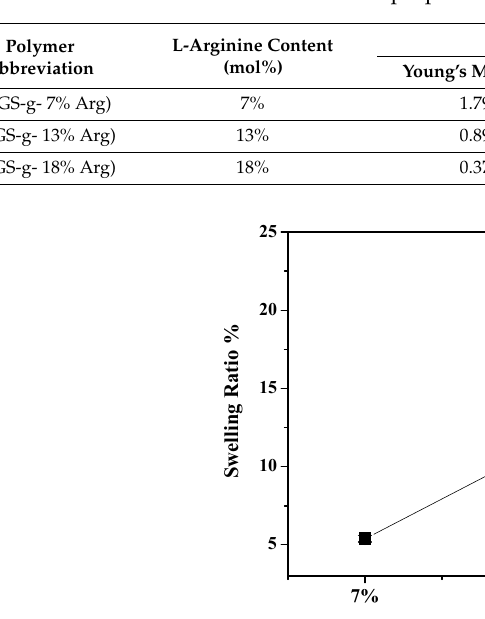
Table 2. Mechanical properties of c(PGS-g-Arg) flims (n = 5).